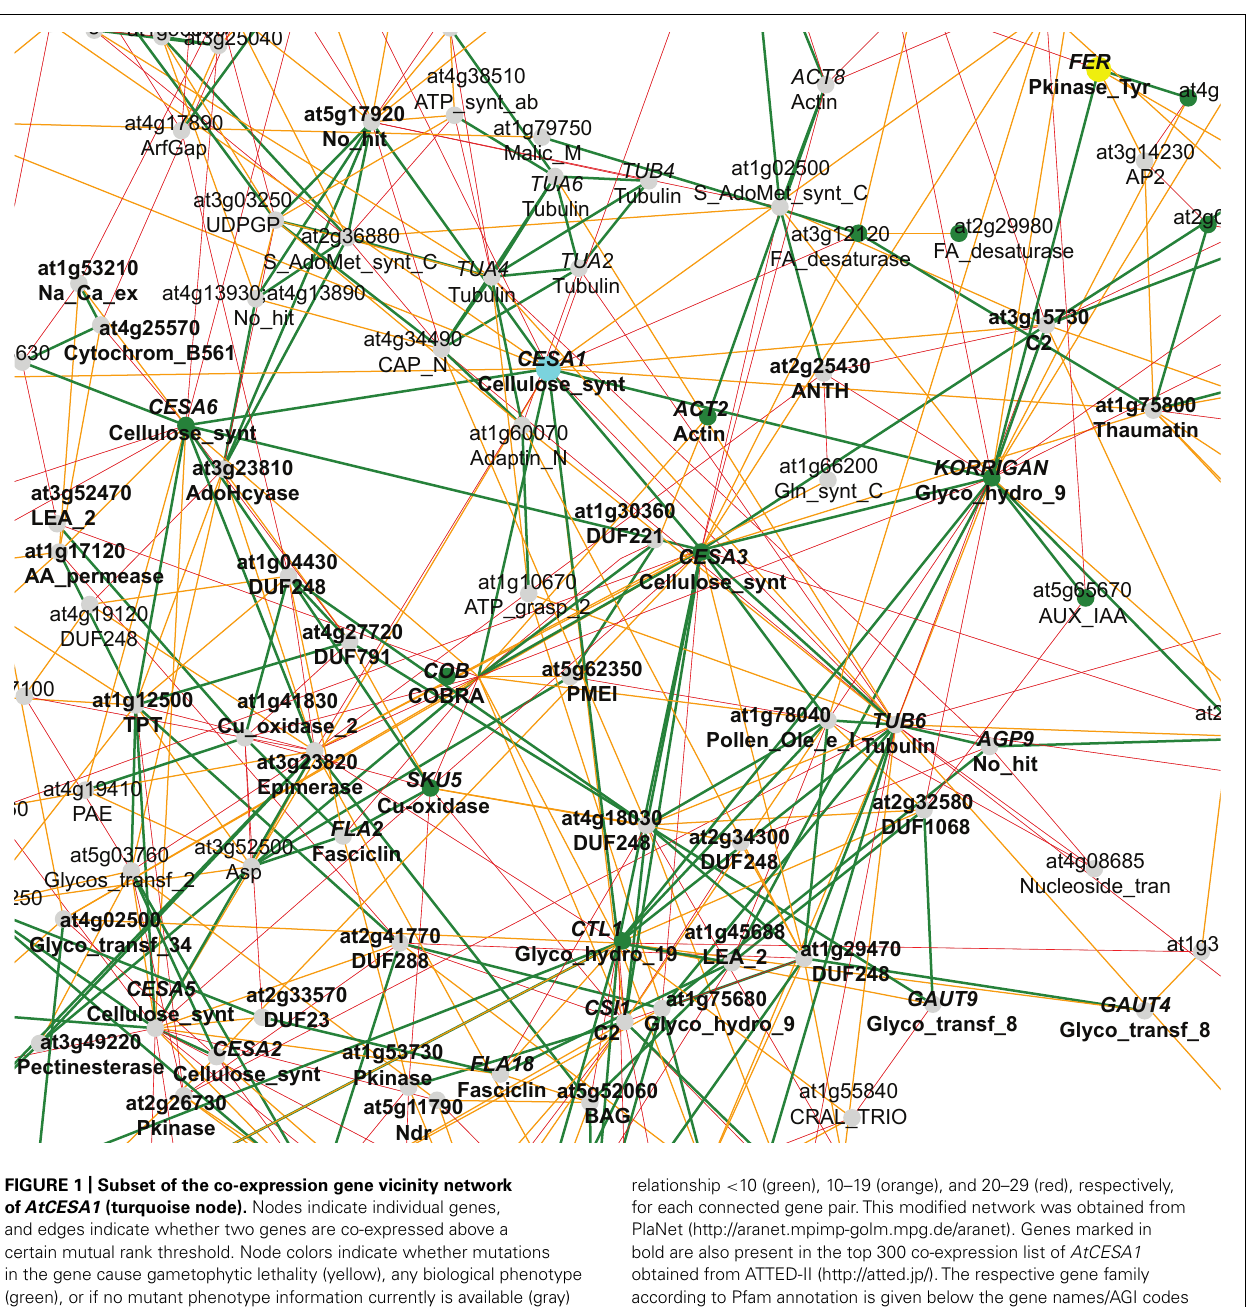
FIGURE 1 | Subset of the co-expression gene vicinity network of AtCESA1 (turquoise node). Nodes indicate individual genes, and edges indicate whether two genes are co-expressed above a certain mutual rank threshold. Node colors indicate whether mutations in the gene cause gametophytic lethality (yellow), any biological phenotype (green), or if no mutant phenotype information currently is available (gray) according toTAIR. Green, orange, and red edges indicate a mutual rank